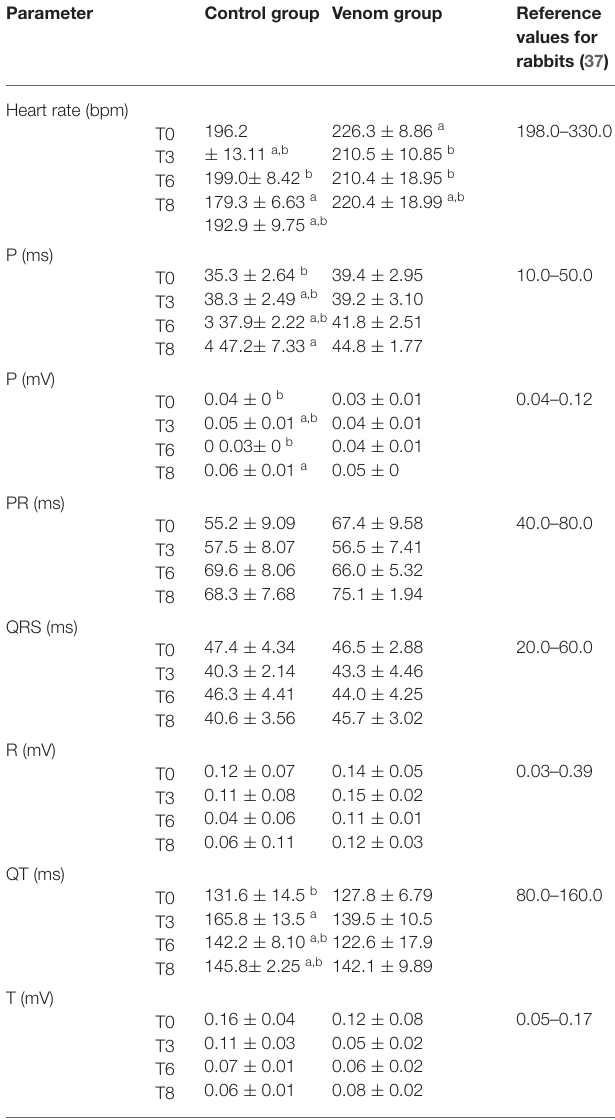
a , b , c Different letters in the same column show statistical difference between experimental moments in the same group (mixed linear model, p < 0.05). Data are presented as mean ±